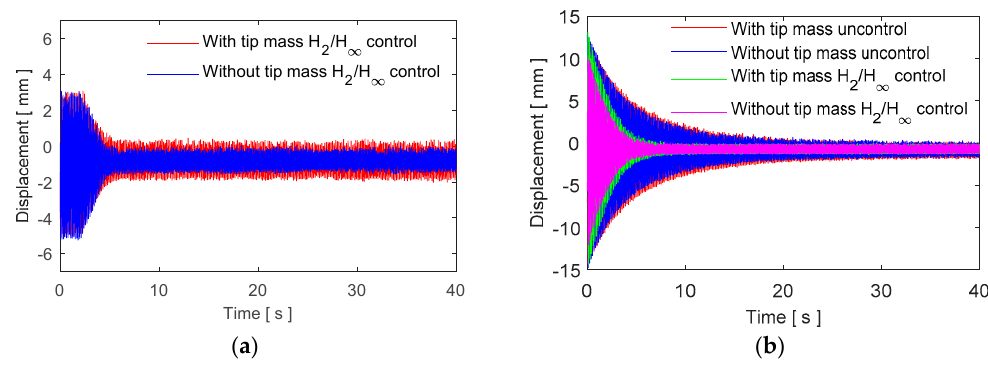
Figure 18. Robustness test results for an additional mass, ( a ) steady state case, ( b ) reference point case.